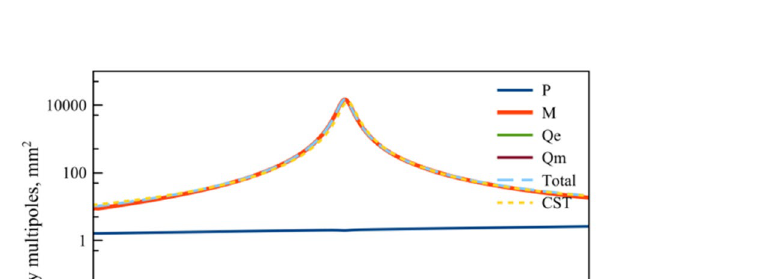
Figure 3. Simulated and measured scattering characteristics of spheroid with aspect ratio a/b = 1.56 in frequency range 1.5–2.5 GHz.